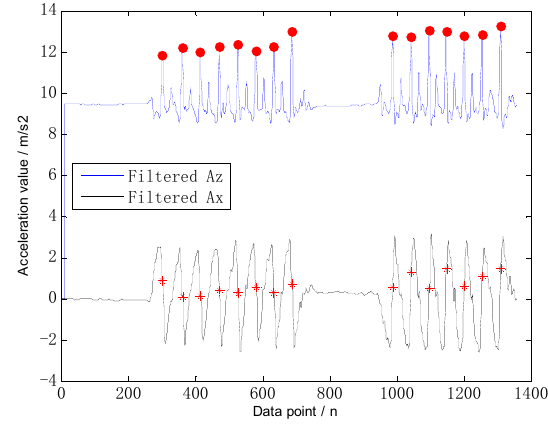
Figure 4. Comparison of lateral walking.